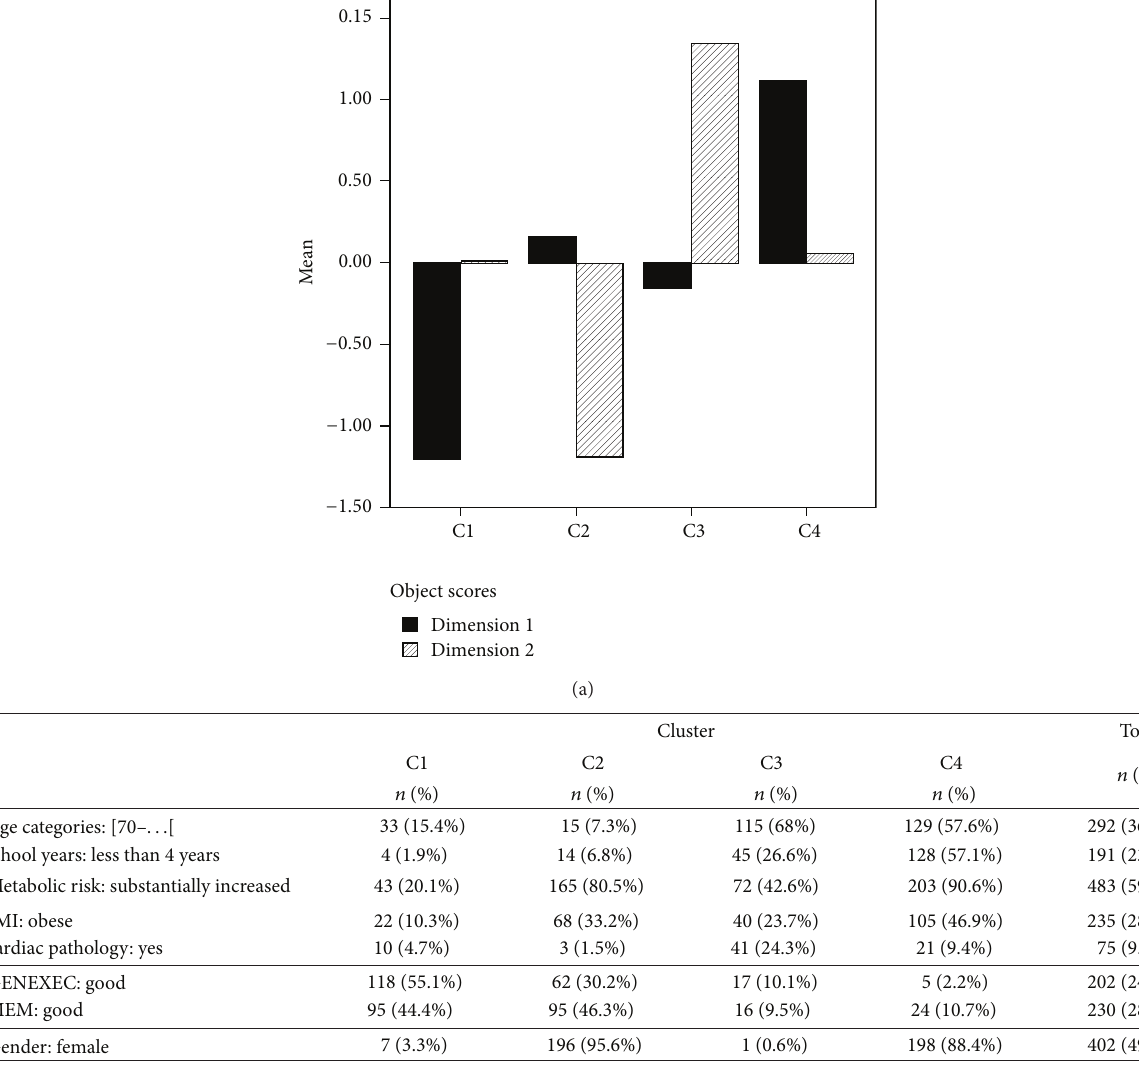
Figure 2: Cluster analysis with object scores. (a) Clusters (clusters 1 to 4, C1 to C4) identified for the MCA dimensions “General/Executive, Lifestyle, and Education” (dimension 1) and “Memory, Clinical, and Age” (dimension 2). (b) Crosstabulations with relevant variables in the MCA (and gender) and cluster